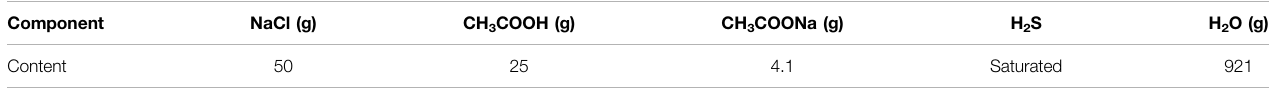
TABLE 2 | Corrosion solution composition.